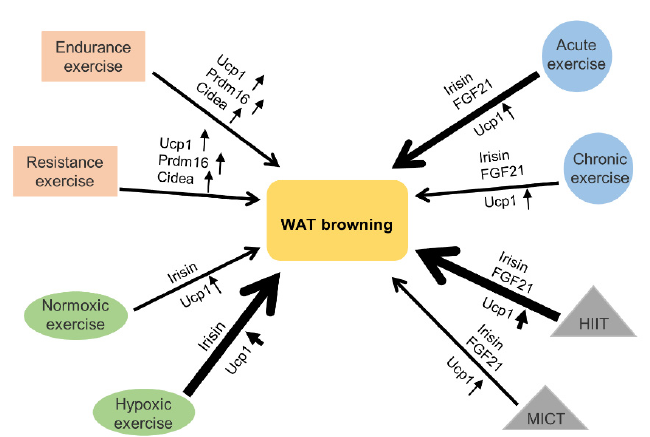
Figure 7. Effects of different exercise programs on the browning of WAT: various types of exercise, including high-intensity interval training (HIIT), moderate intensity continuous training (MICT), acute exercise, chronic exercise, normoxic exercise, hypoxic exercise, aerobic exercise and resistance exercise can mediate the browning of WAT. Among them, HIIT can promote WAT browning more effectively than MICT. Acute exercise can promote WAT browning more effectively than chronic exercise. Hypoxic exercise can promote WAT browning more effectively than normoxic exercise. The expression levels of browning-related genes, such as Ucp1, Prdm16 and Cidea are up-regulated in WAT after many different types of exercise. Irisin and FGF21 are involved in promoting WAT browning and are mediated by many different types of exercise. The thickness of the arrow indicates the strength of the effect exerted by exercise. The thicker the arrow is, the stronger the effect